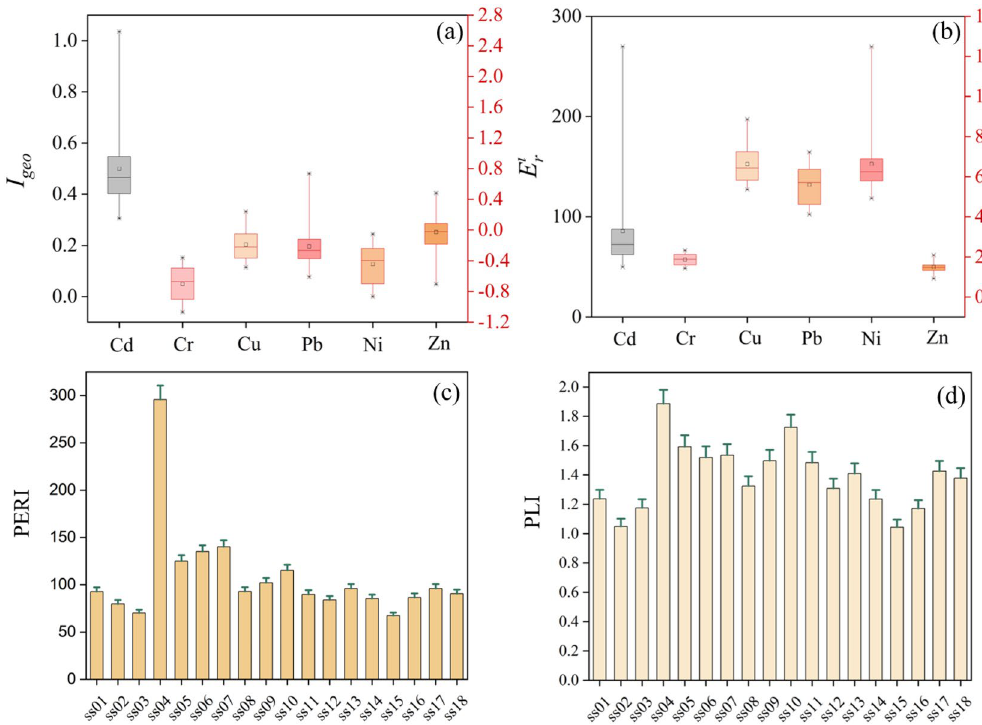
Figure 5. Contamination and ecological risk indices: ( a ) geoaccumulation index ( Igeo ) of HMs; ( b ) ecological risk of individual HMs; ( c ) potential ecological risk index (PERI) of HMs; ( d ) pollution load index (PLI) of